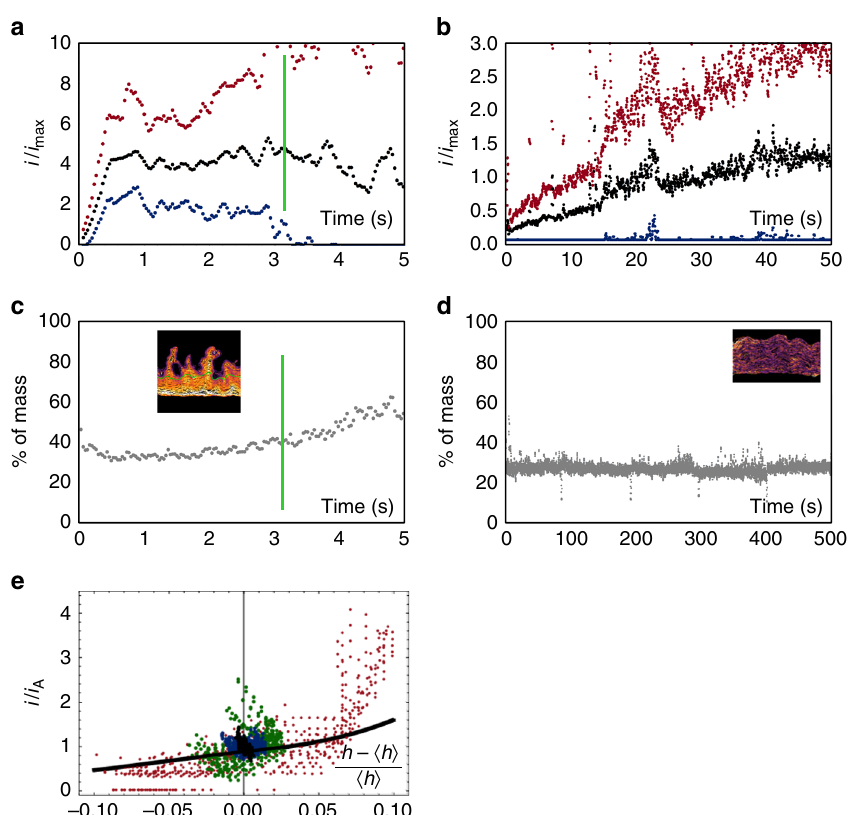
Fig. 3 The pattern of current fl ow at the growth front during deposition. a , b Experimental maximum, minimum, and average current density obtained from the line pro fi le plots in Figs 1b and 2b, respectively. The values are normalized by dividing by the maximum current that could be sustained by planar diffusion at that time given that current i has already fl own for time t , where i = 1550 and 35 A m − 2 for a and b , respectively. c , d Percent of mass added to the top quartile of points during the experiments shown in Figs 1 and 2, respectively. Noise in a – d re fl ects errors in aligning adjacent movie frames. e Relationship between normalized current density and deviation from mean height for diffusion-limited growth of a sinusoidal pro fi le calculated from ref. 34 (black line). Growth data from Fig. 1 are shown at t = 0.0 s (black), 2.0 s (blue), 3.0 s (green), and 3.8 s (Fig. 3e) relating the deviation from the average current density, i / (cid:1) h h i . Here, i is the i A , to the deviation from the mean height, h h h i current density, h the interface height at a point, and, i A and h h i the average values. Figure 3e also shows the experimental data.